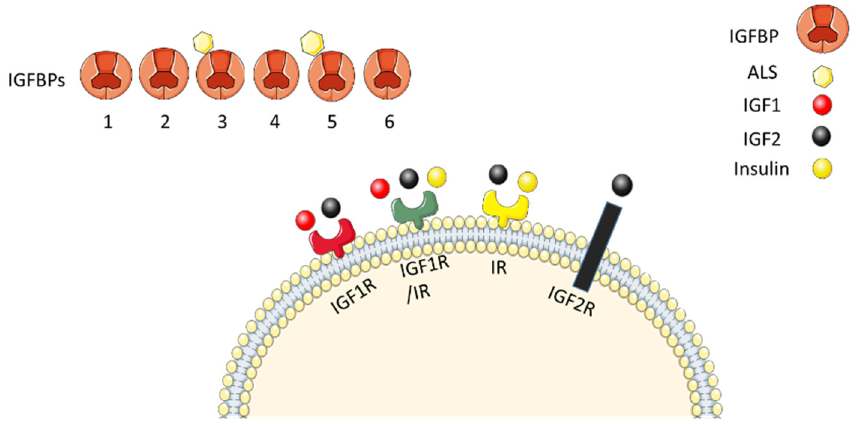
Figure 1. Components of IGF axis.